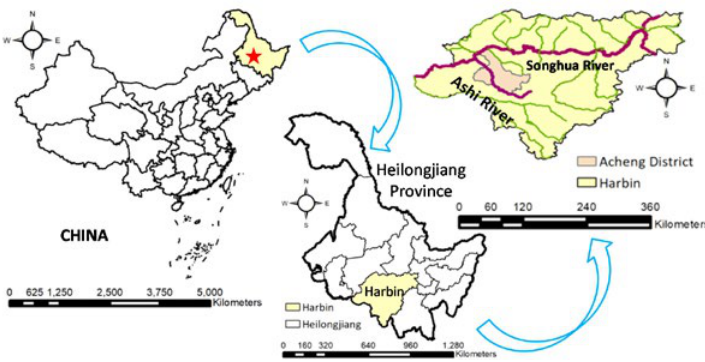
Fig. 1: Geographic location of the study area in Ashi River and Acheng District